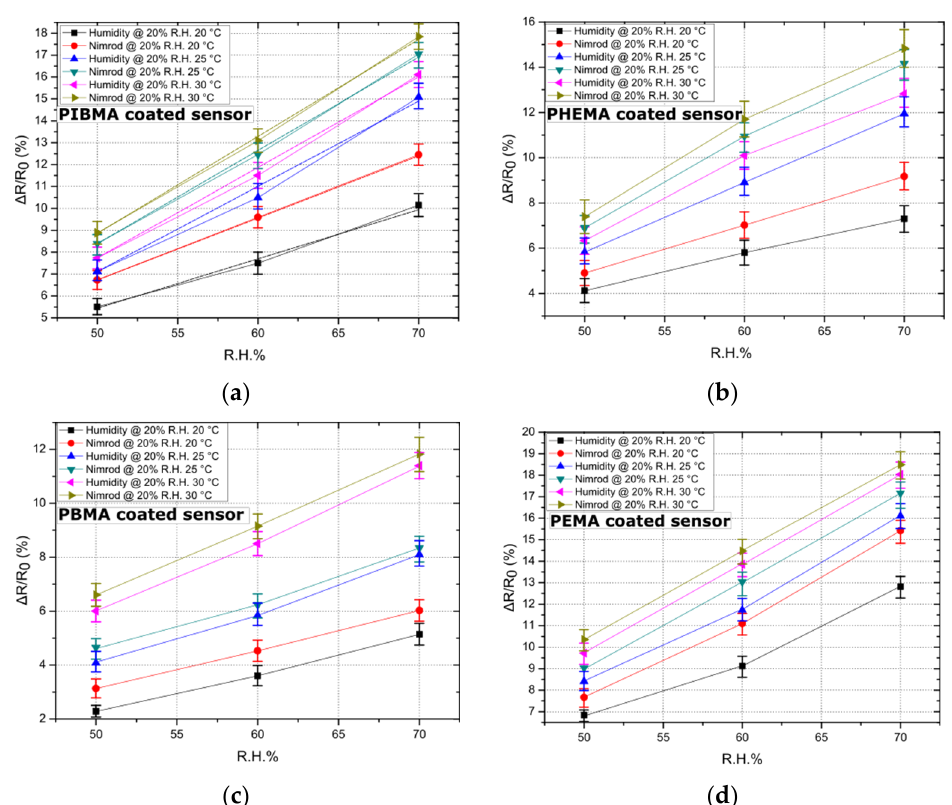
Figure 3. The effect of temperature on sensor response. Data points correspond to the mean response of five sensors (coated with each of the four polymers), while the standard deviation is illustrated by error bars. Sensors have been exposed to three temperatures: 20, 25, and 30 °C, while linear fitting has been performed in the case of the best performing sensor (i.e., sensors functionalized with PIBMA polymer) to showcase the linearity of the sensors’ response. ( a ) Response of 5 PIBMA coated sensors in Nimrod and R.H.; standard deviation from 0.42% to 0.66%. Linear fitting has been performed and is illustrated by dashed lines. The adjusted R-square value for the linear fit regression was found to be between 0.98567 and 0.99999. ( b ) Response of 5 PHEMA coated sensors in Nimrod and R.H.; standard deviation from 0.58% to 0.86%. ( c ) Response of 5 PBMA coated sensors in Nimrod and R.H.; standard deviation from 0.25% to 0.71%. ( d ) Response of 5 PEMA coated sensors in Nimrod and R.H.; standard deviation from 0.26% to